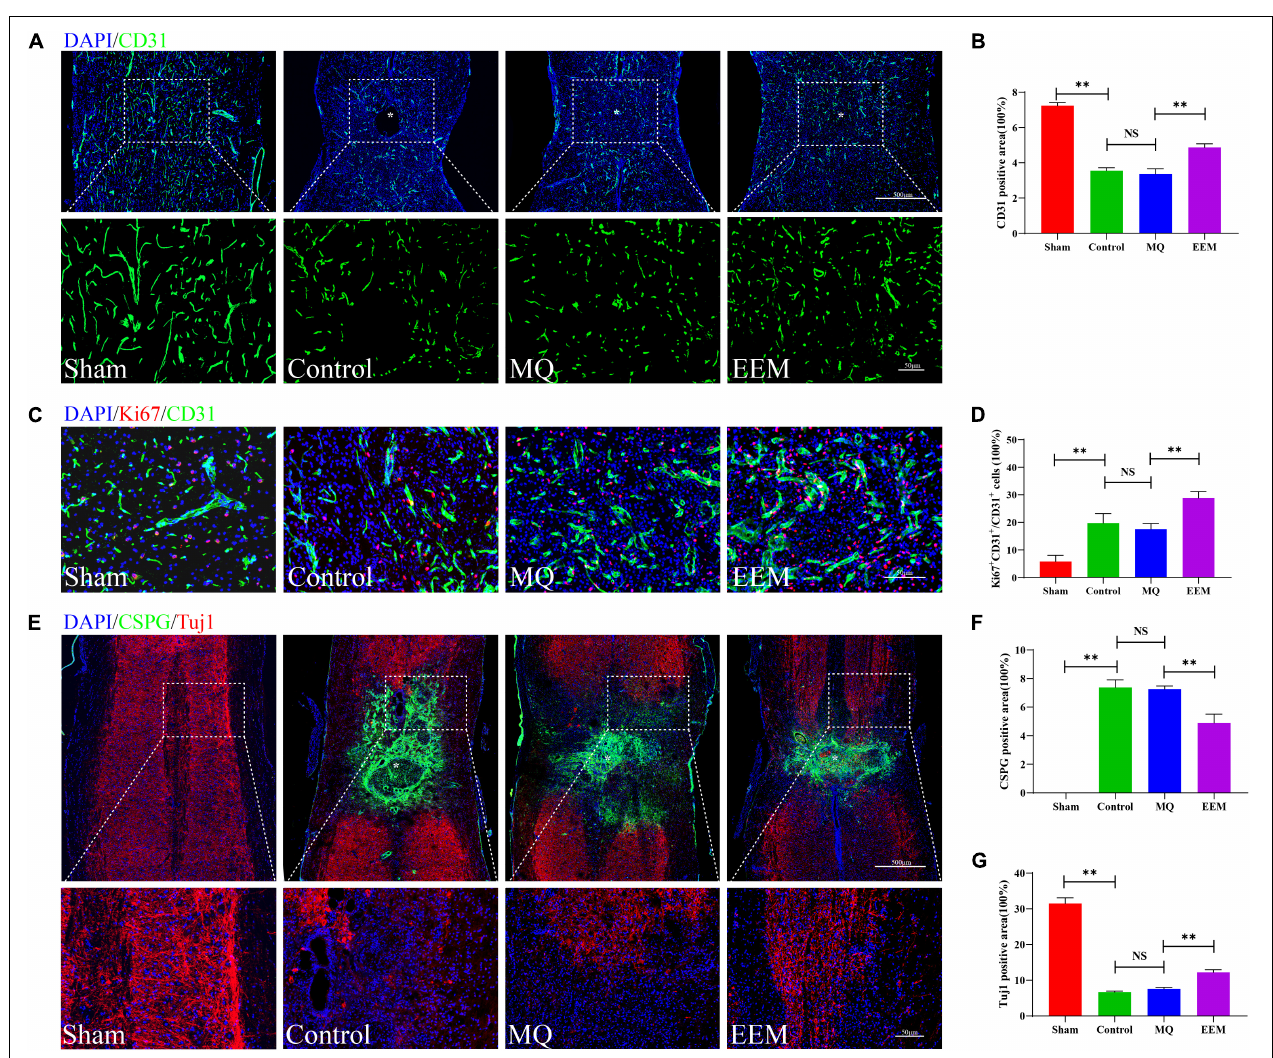
FIGURE 6 | EEM promote angiogenesis and axon growth after SCI. (A) Representative immunofluorescence images of CD31 (green) in the different treatment groups. Scale bars: 500 µ m (upper panel), 50 µ m (lower panel). (B) Quantification of CD31-positive areas in (A) [ F (3, 12) = 276.1, p < 0.01. Tukey’s post hoc test. Control vs. Sham, p < 0.01; MQ vs. Control, p = 0.63; MQ vs. EEM, p < 0.01; n = 6 animals for each group]. (C) Representative immunofluorescence images of CD31 (green) and Ki67 (red) in the different treatment groups. Scale bars: 50? µ m. (D) Quantification of ratio of CD31 + Ki67 + /CD31 + cells in (C) [ F (3, 12) = 53.98, p < 0.01. Tukey’s post hoc test. Control vs. Sham, p < 0.01; MQ vs. Control, p = 0.63; MQ vs. EEM, p < 0.01; n = 6 animals for each group]. (E) Representative immunofluorescence staining of Tuj-1 (red) and CSPG (green) in different treatment groups. Nuclei were stained with DAPI (blue). Scale bars: 500 µ m (upper panel), 50 µ m (lower panel). (F) Quantification of CSPG-positive areas in (E) [ F (3, 12) = 265.2, p < 0.01. Tukey’s post hoc test. Control vs. Sham, p < 0.01; MQ vs. Control, p = 0.98; MQ vs. EEM, p < 0.01; n = 6 animals for each group]. (G) Quantification of Tuj-1 positive areas in (E) [ F (3, 12) = 665, p < 0.01. Tukey’s post hoc test. Control vs. Sham, p < 0.01; MQ vs. Control, p = 0.49; MQ vs. EEM, p < 0.01; n = 6 animals for each group]. The data are presented as the means ± SD. * p < 0.05, ** p < 0.01, NS = Not